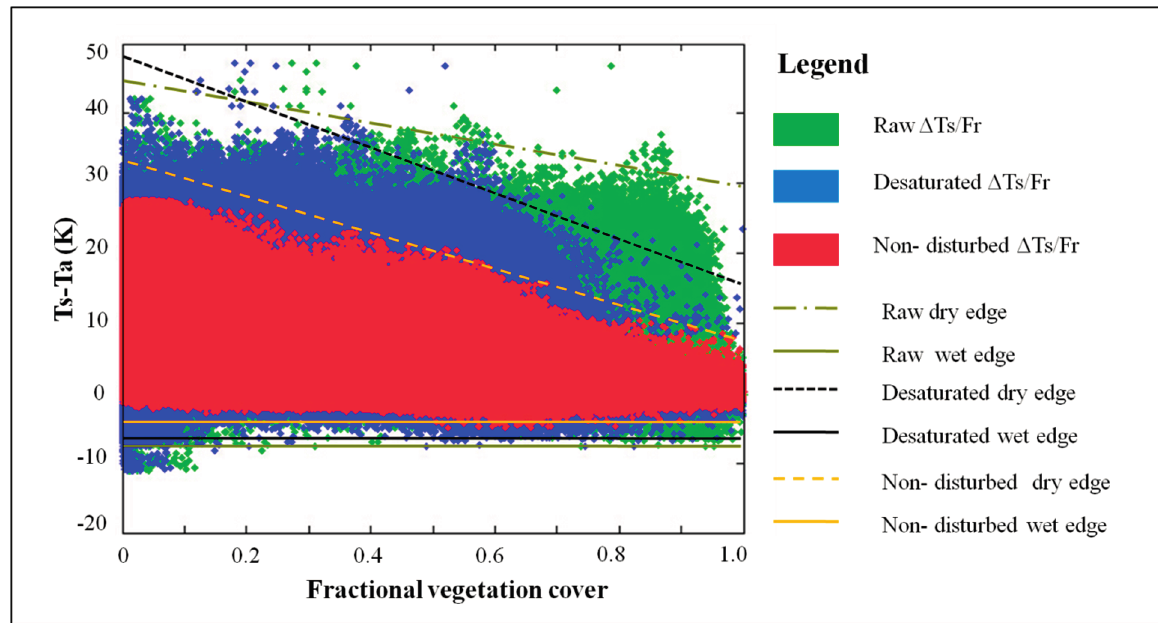
Figure 5. The initial and improved ∆T